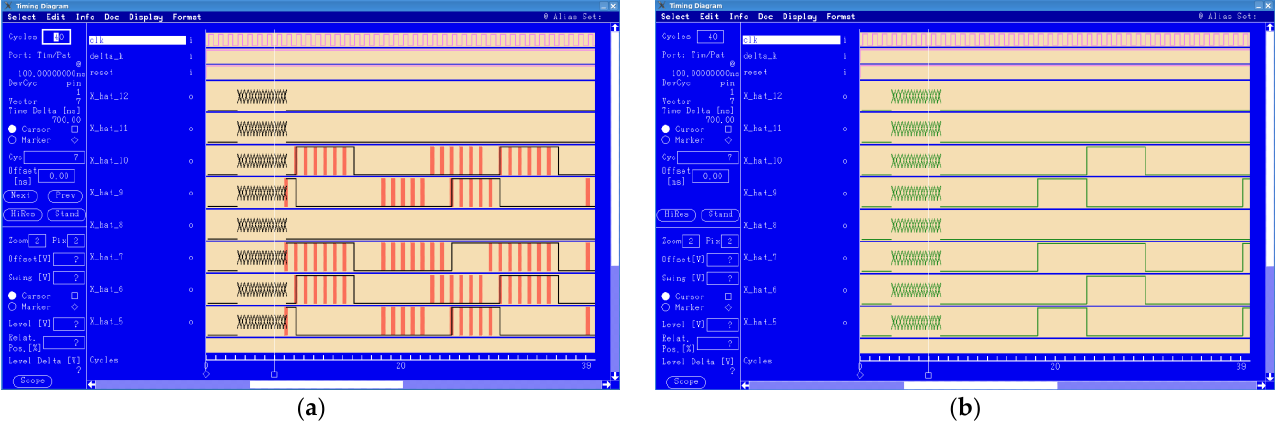
Figure 17. ( a ) Actual wave of V93000 measuring machine. ( b ) Ideal wave of V93000 measuring ma- chine.